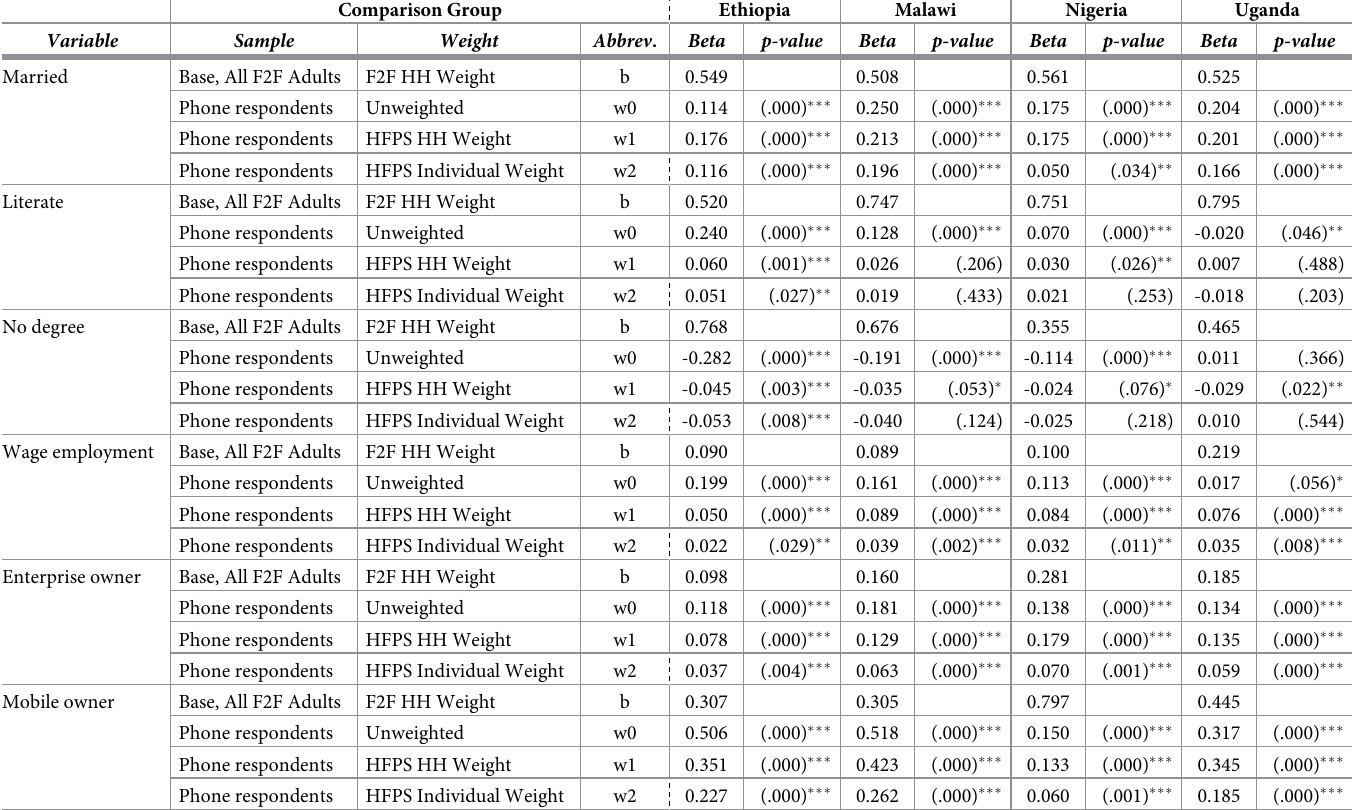
Table 5. Tests of mean differences between face-to-face (F2F) adults and phone respondents: Marital status, education, employment–as measured in the F2F